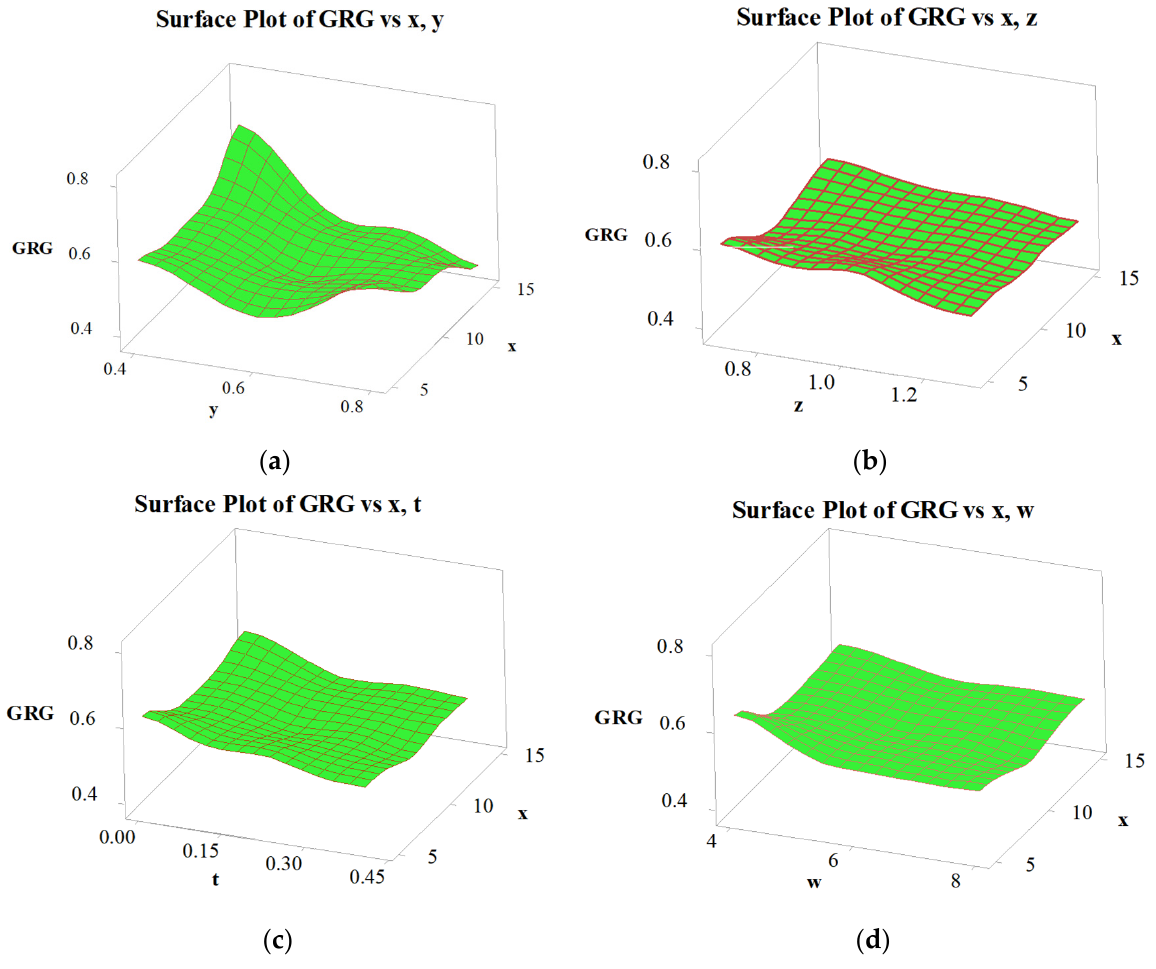
Figure 6. Surface plot for GRG. ( a ) Surface plot of GRG with x, y; ( b ) Surface plot of GRG with x, z; ( c ) Surface plot of GRG with x, t; ( d ) Surface plot of GRG with x, w.